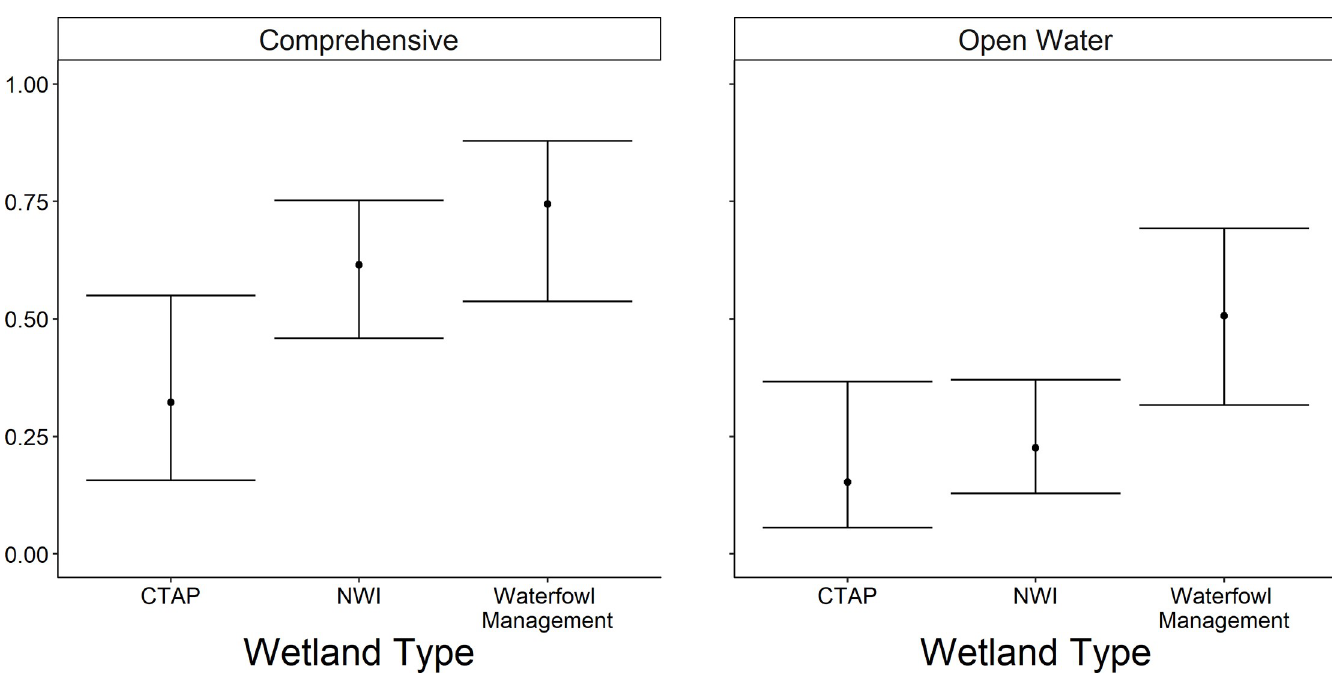
Fig 5. Predicted probability (95% confidence limits) of site occupancy for the comprehensive group across wetlands managed for waterfowl, Critical Trends Assessment Program (CTAP), and National Wetland Inventory (NWI) site types in Illinois during late spring and early summer 2015–2017. Each box represents one grouping of species, labeled at the top, all species in open water are in